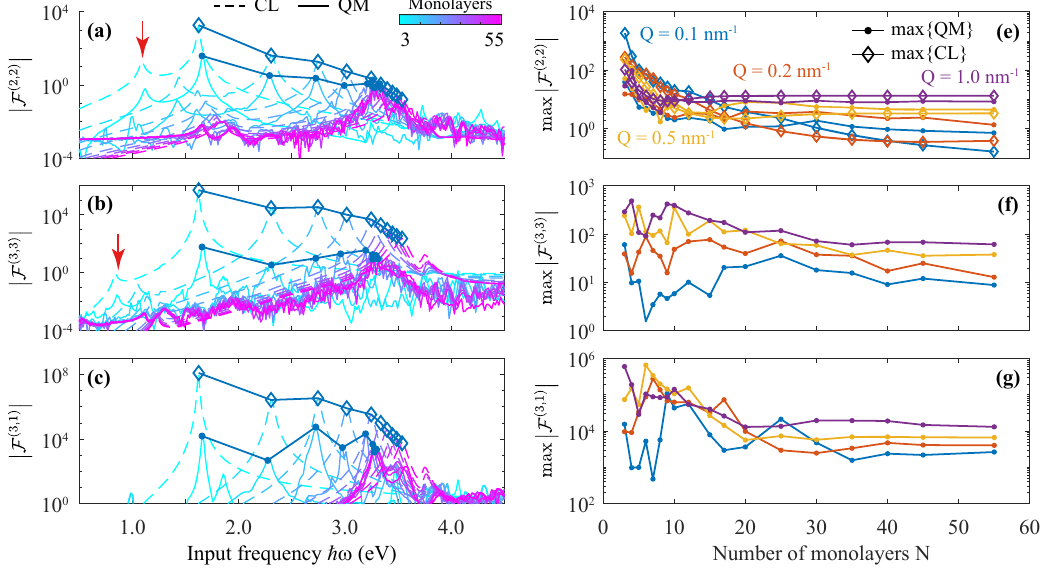
Figure 3: Nonlinear figure of merit. (a)–(c) Calculated figure of merit  ( n , s ) as a function of the input frequency with fixed in-plane wave vector Q = 0 . 1 nm − 1 for (a) SHG, (b) THG, and (c) the Kerr effect. We consider a range of film thicknesses as indicated by the color scale. Solid and dashed curves correspond to QM and CL simulations, whose peak maxima are tracked with solid and open symbols, respectively. Red arrows in (a,b) highlight the SHG and THG replica of the plasmonic peak, equivalent to those of Figure 2. (e)–(g) Variation of the maxima of  ( n , s ) as a function of film thickness for a set of in-plane wave vectors (see colored labels in